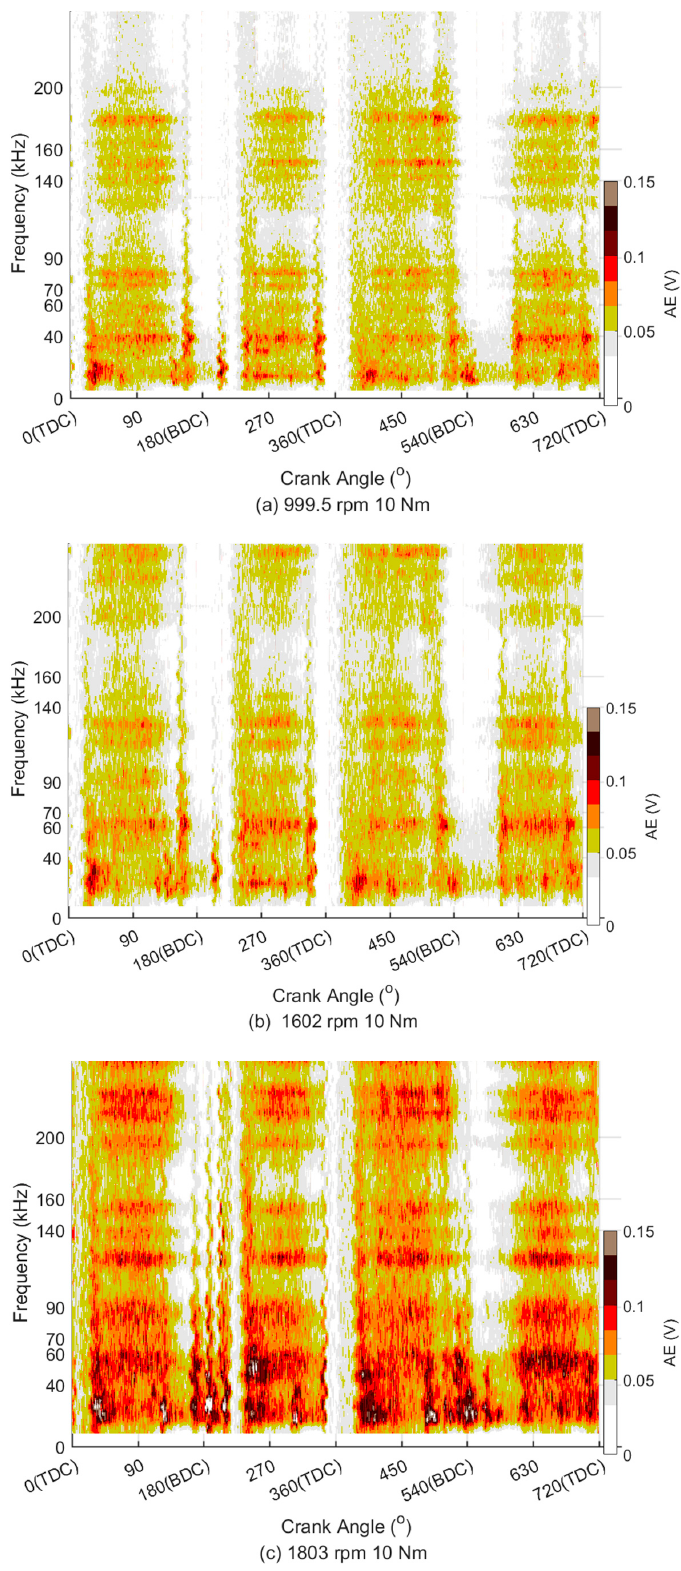
Figure 7. WPT spectrum of threshold AE for 10W30 oil by db4 wavelet: ( a ) 999.5 rpm 10 Nm; ( b ) 1602 rpm 10 Nm; ( c ) 1803 rpm 10 Nm.